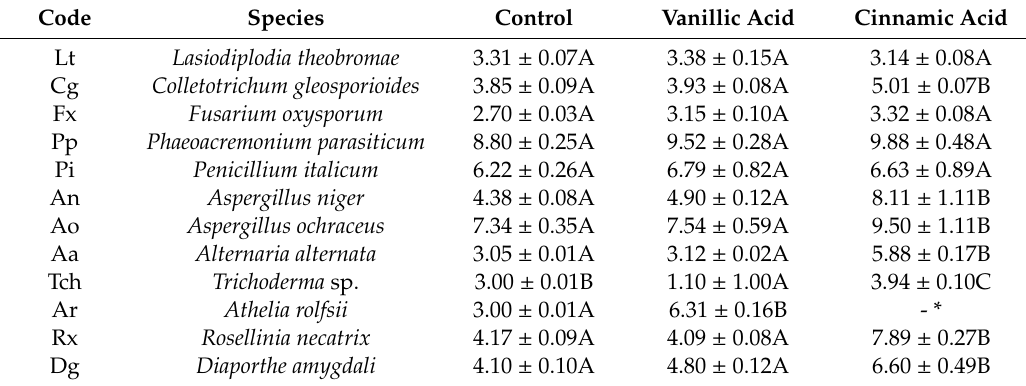
Table 2. Time to attain to half maximum diameter of the fungal colony (D max ) (days) (mean ± standard error). For each fungal strain, di ff erent letters indicate significant di ff erences ( p < 0.05) in their radial growth on the three media (control and supplemented with vanillic or cinnamic acid). * no